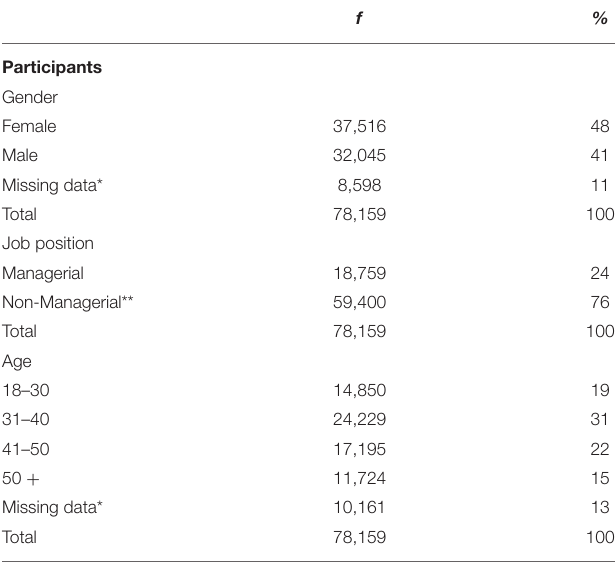
TABLE 1 | Descriptive statistics of the samples included in the